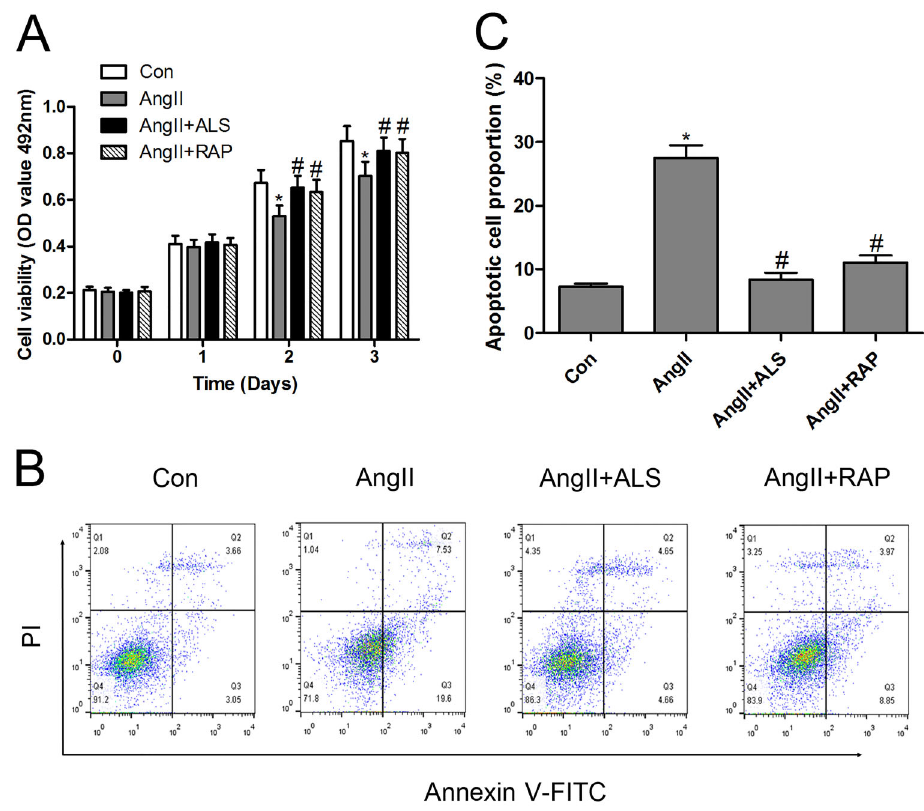
Figure 6. Aliskiren (ALS) improved cell viability and inhibited apoptosis in Ang II-treated H9C2 cardiomyocytes. After H9C2 cardiomyocytes were treated with Ang II (10 m M), Ang II (10 m M) + ALS (20 m M), or Ang II (10 m M) + RAP (100 nM), ( A ) the cell viability was monitored using MTS assay at 24, 48, and 72 h, and ( B and C ) apoptosis was analyzed using fl ow cytometry at 48 h (n=3 per group). Data are reported as means ± SE. *P o 0.05 compared with control; # P o 0.05 compared with the Ang II-treated group (ANOVA followed by Tukey ’ s post hoc test). Ang: angiotensin; RAP: